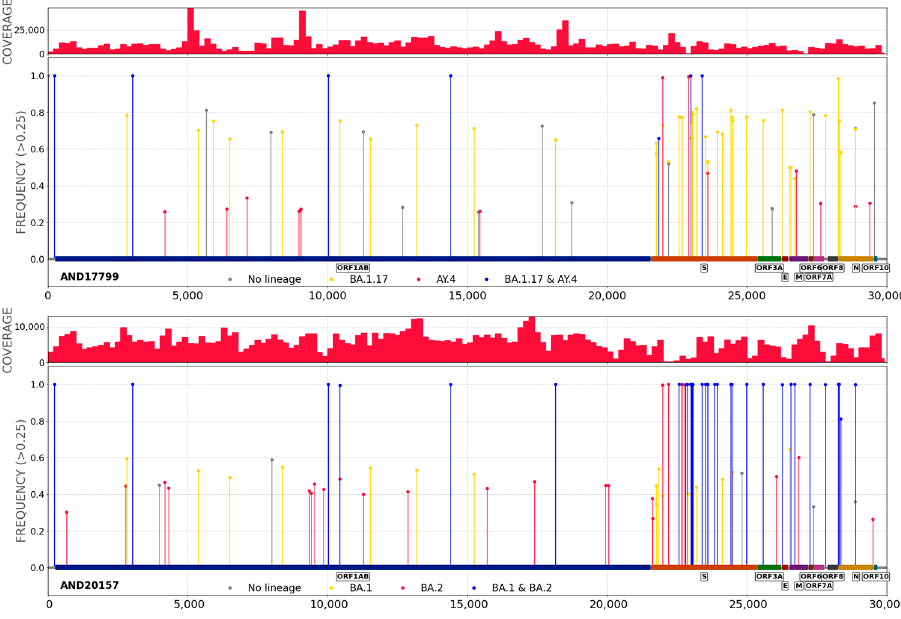
Figure 2. Mutation frequency plots of: ( upper panel ) delta-omicron (sample AND17799), co-infection, and ( lower panel ) omicron-omicron (sample AND20157) BA.1-BA.2 co-infection.